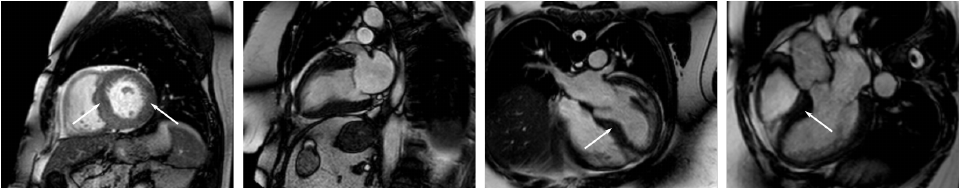
Figure A4. Short-axis cine image and long-axis cine images demonstrate concentric left ventricular hypertrophy with subtle septal predominance (white arrows), in a patient with Anderson–Fabry disease.